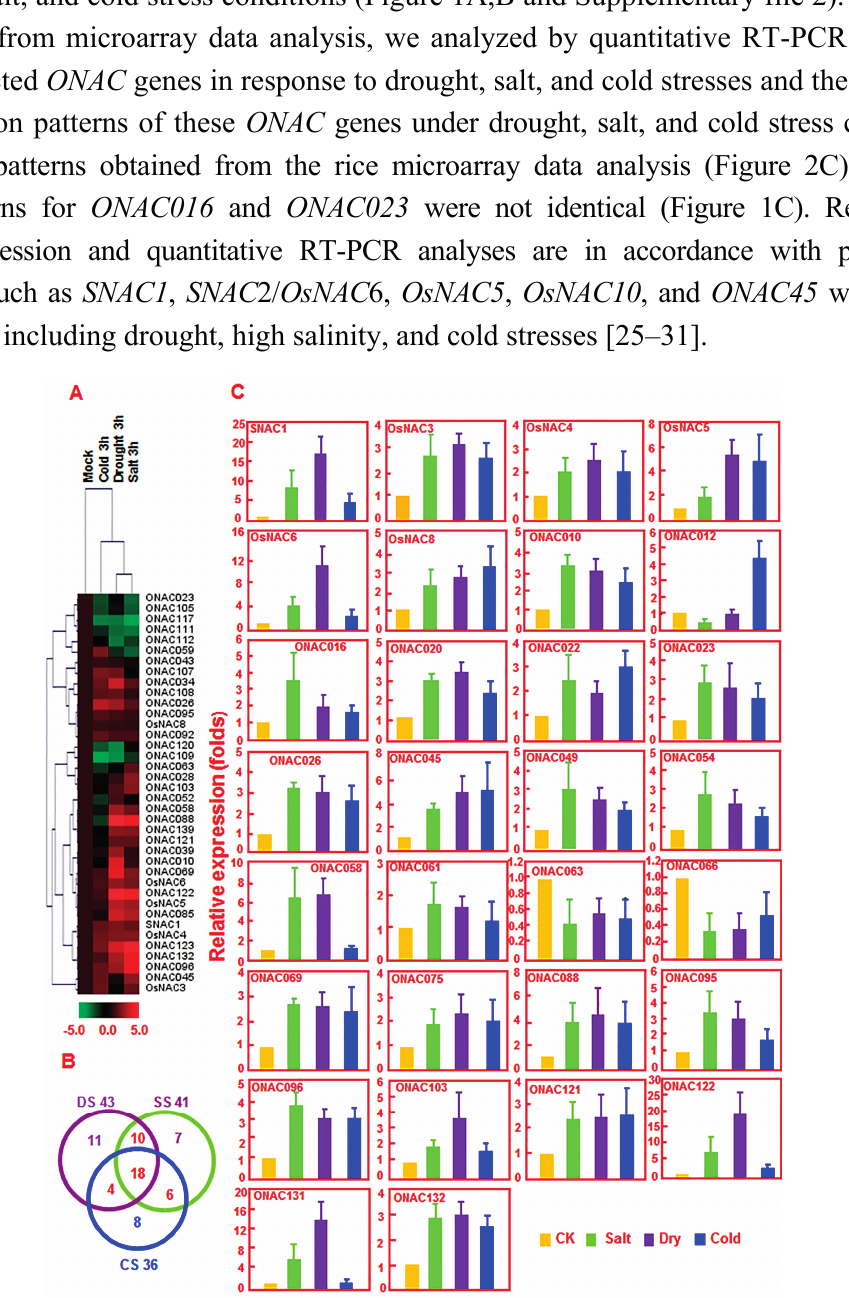
Figure 1. Overlapping expression of ONAC genes in response to various abiotic stress conditions. ( A ) Heat map of ONAC genes showing differential expression patterns under at least two abiotic stress conditions. The change values in treated samples vs.